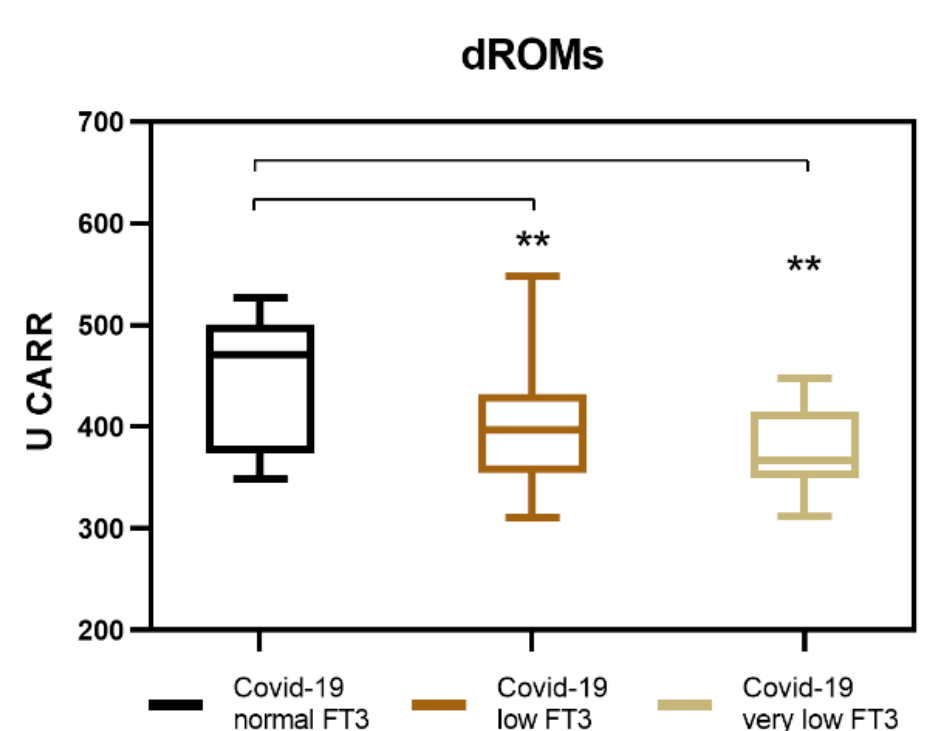
Figure 1. Measurement of reactive oxygen species (ROS) in COVID-19 patients with NTIS. ** p < 0.005.